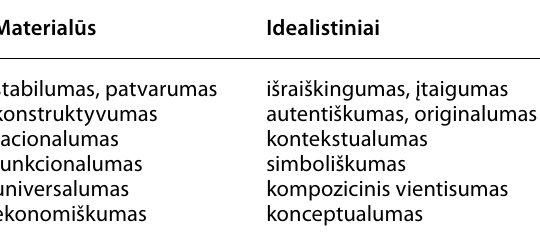
Table 1. Factors determining form